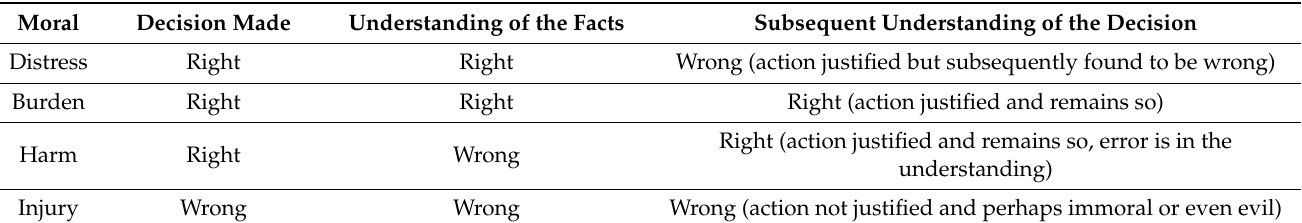
Table 3. Moral effects of